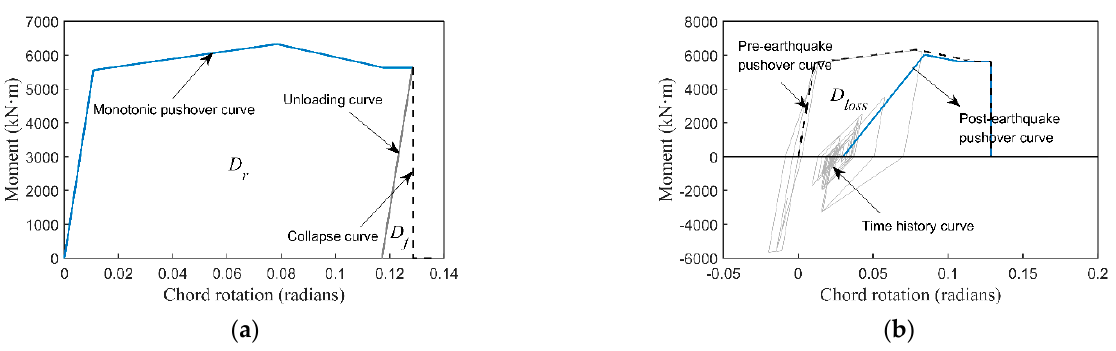
Figure 3. Schematic illustration of the MDBI quantification procedure: ( a ) Monotonic pushover curve of the intact structure; ( b ) Monotonic post − earthquake pushover curve of the damaged structure.